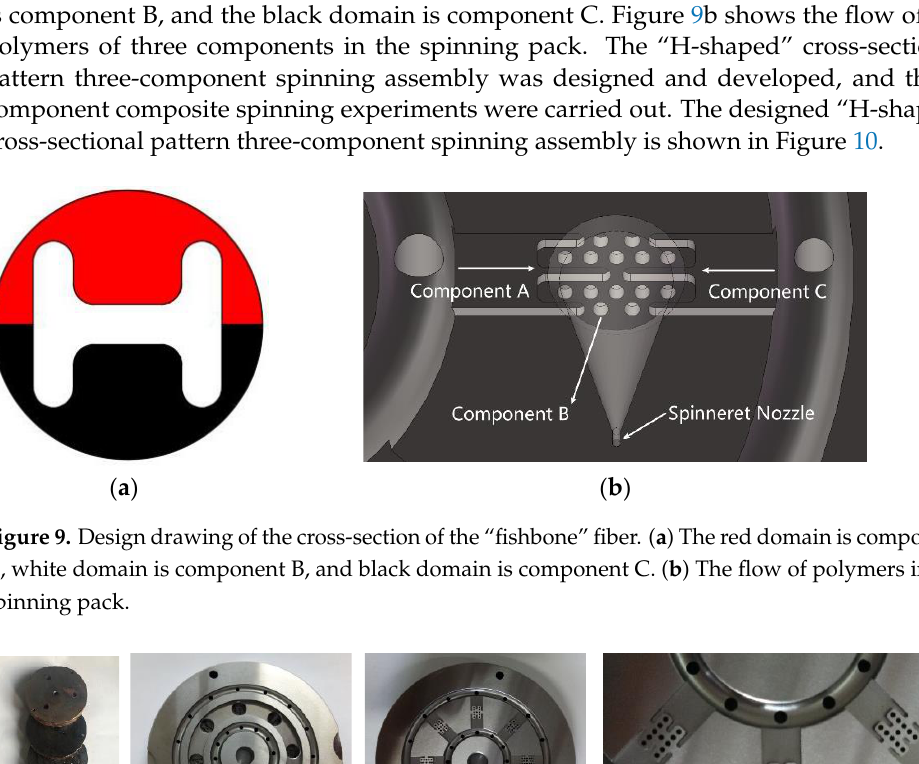
Figure 9. Design drawing of the cross-sectio n of the “fishbone” fiber. ( a ) The red domain is compo- nent A, white domain is component B, and black domain is component C. ( b ) The flow of polymers in the spinning pack. Figure 10. The spinning pack for the fiber with an “H-shaped” cross-section. ( a ) The spinning pack assembly; ( b ) top view of the distribution board; ( c ) bottom view of the distribution board; ( d ) partial view of the distribution board.